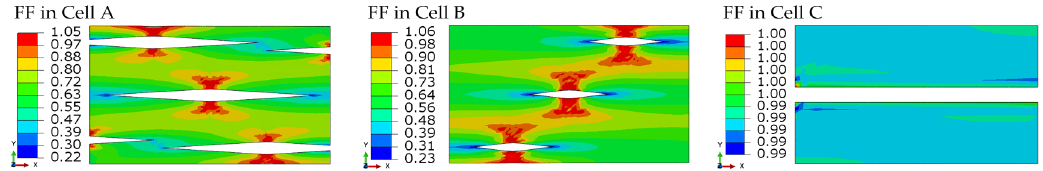
Figure 8. The fiber fracture (FF) failure modes in the unit cells under longitudinal tensile.